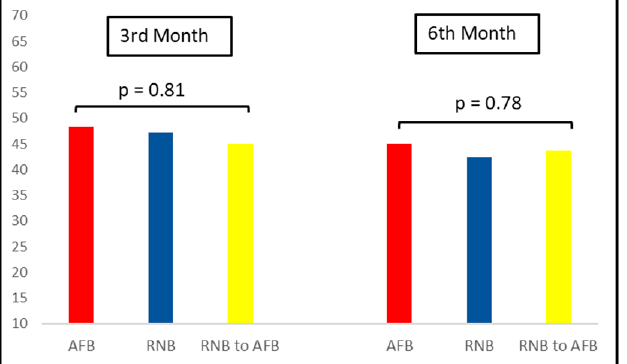
Figure 2. The percentages of eyes that demonstrated a decrease in central macular thickness (CMT) ≥ 20% at month 3 and month 6 among study groups.